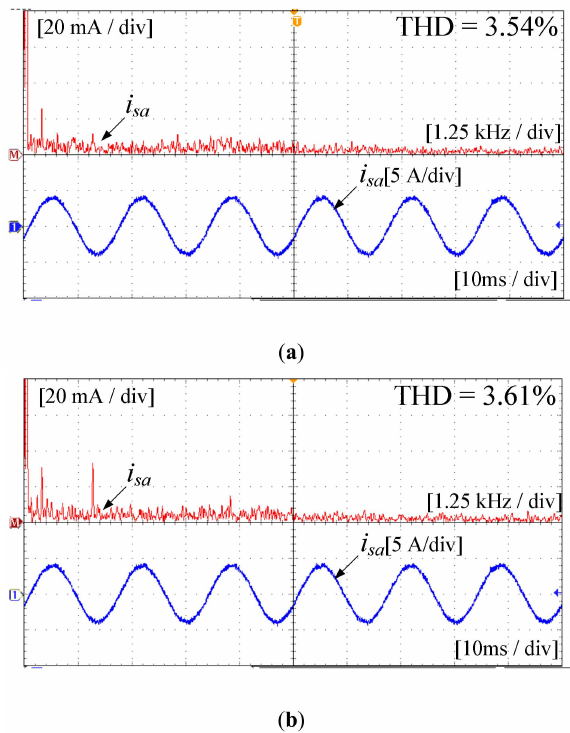
Figure 11. Experimental waveforms of FFT analysis of the a -phase source current obtained from ( a ) the conventional algorithm and ( b ) the proposed algorithm.